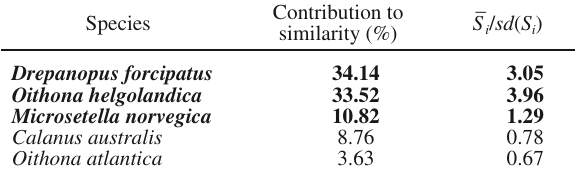
Table 3. – SIMPER analysis. List of copepod species with major contributions to similarity over the southern Patagonian shelf. The percentage contributed by each species to similarity and the ratio between its average similarity value and the standard deviation of its contribution are indicated. Average between sample similarity in the S– entire area ( ) was 59%. Taxa were ranked in order of decreasing i average contribution to similarity. Typical species are in bold (see Materials and Methods for details).